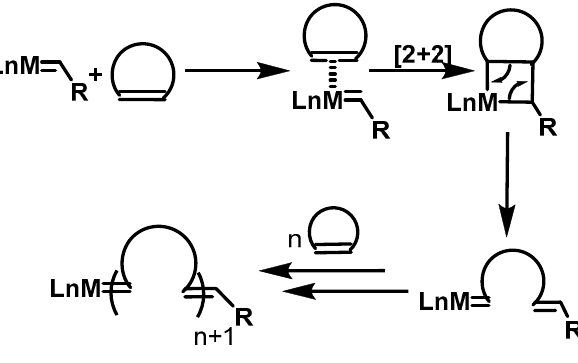
Scheme 1. General mechanism of ROMP.